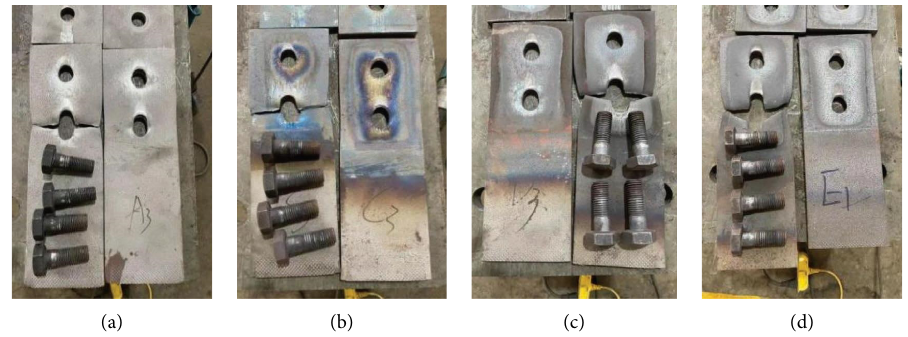
Figure 4: Failure of fre-resistant high-strength bolt specimens. (a) A3. (b) C3. (c) D3. (d)